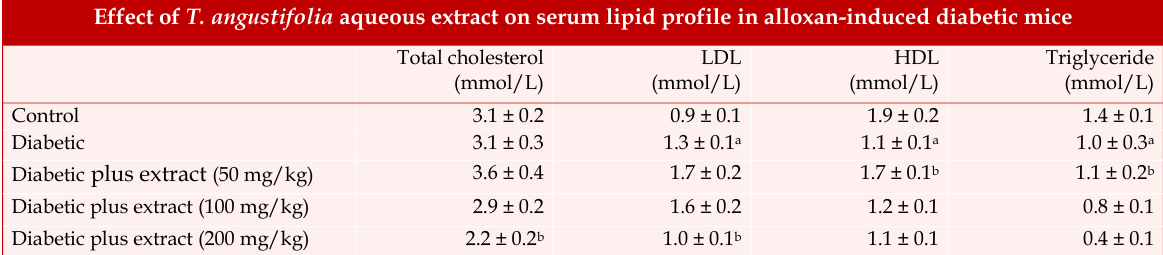
Effect of T. angustifolia aqueous extract on serum lipid profile in alloxan-induced diabetic